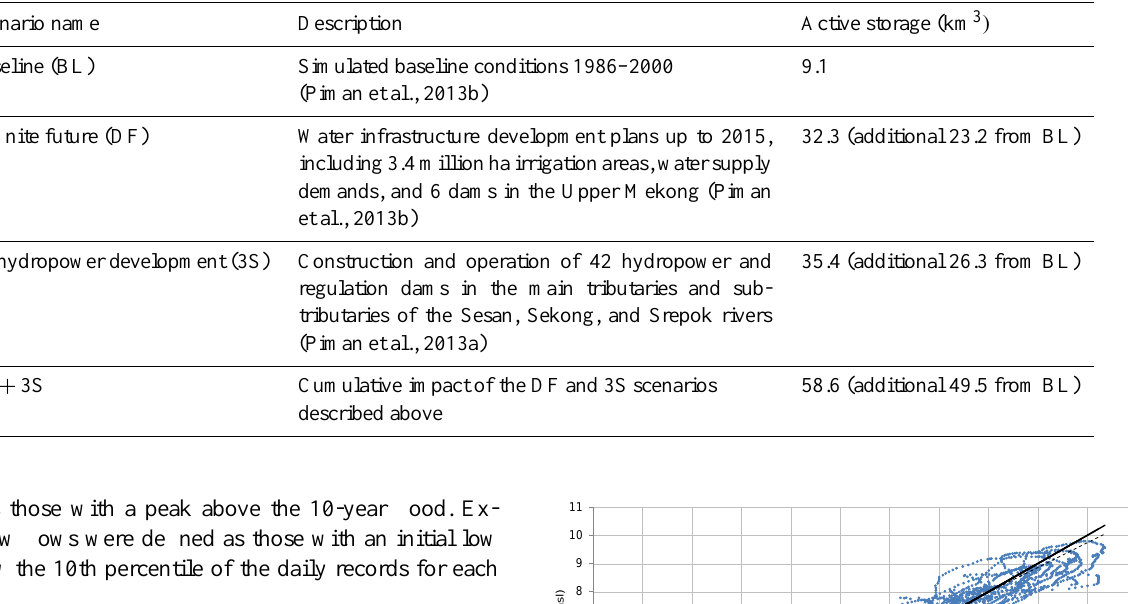
Table 1. Description of water infrastructure development scenarios.